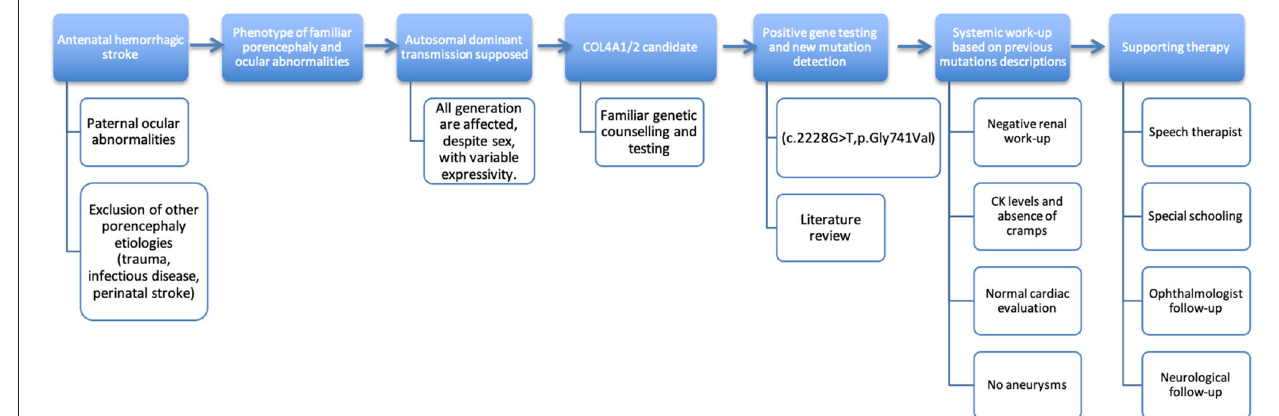
FIGURE 2 | Timeline.